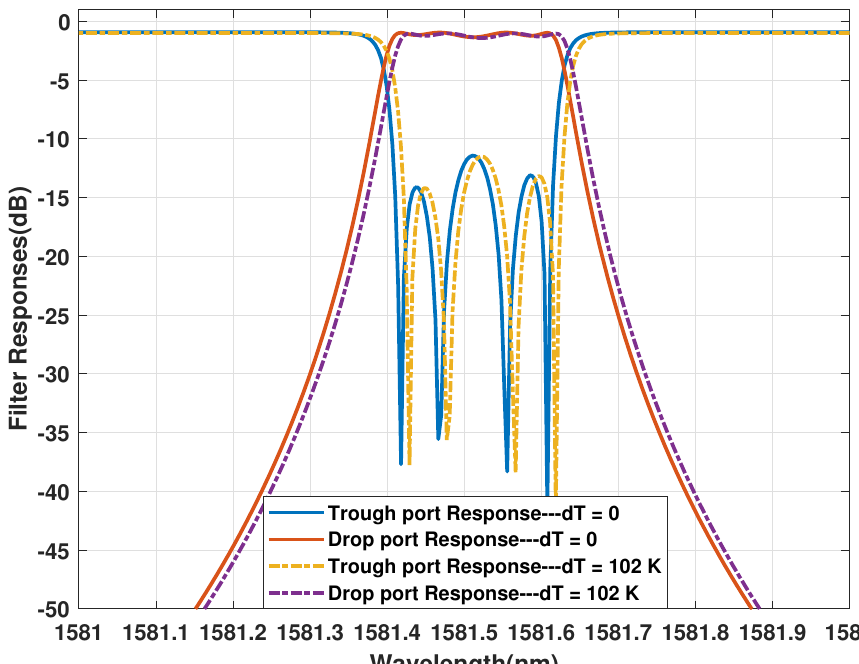
Figure 13. S-parameters affected by a heat source from the substrate. The filter responses at through and drop ports are slightly shifted at a rate of 0.09 pm/K.